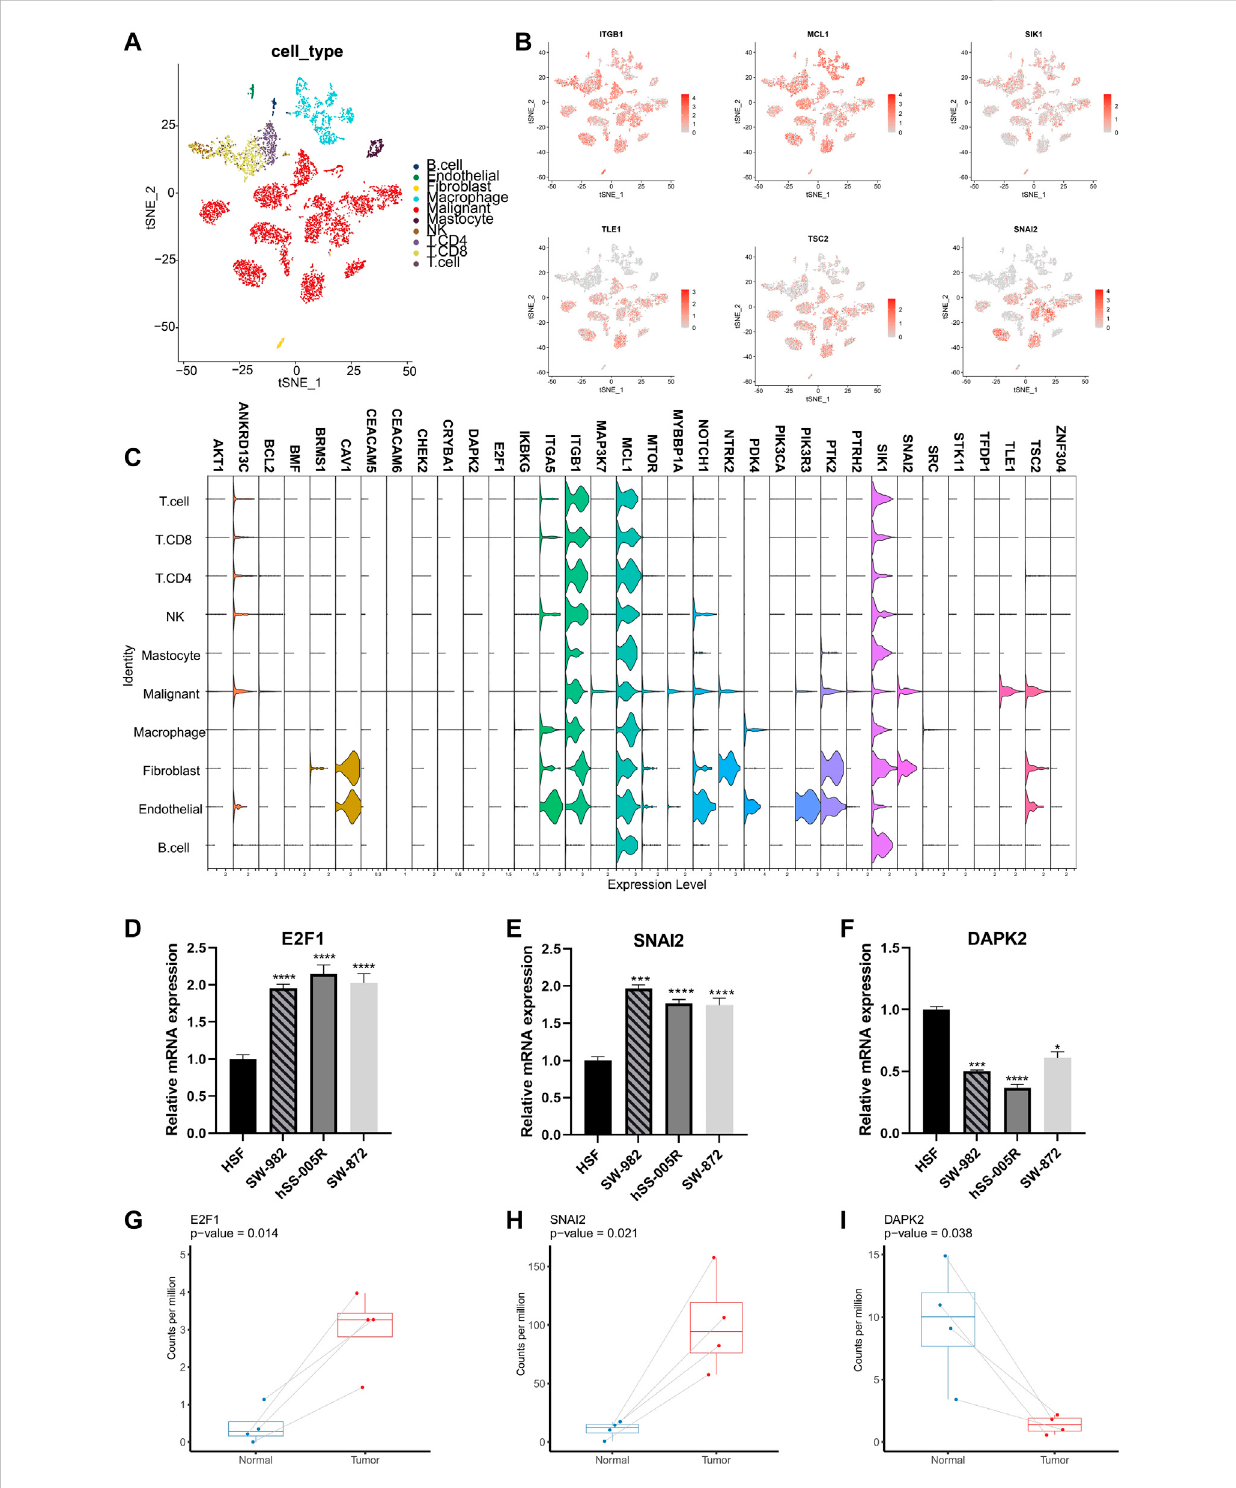
FIGURE 3 Validation of expression patterns of ARGs at single-cell resolution. (A) The t-distributed stochastic neighbor embedding (t-SNE) plot showing speci fi c cell types of STS. (B) The t-SNE plots showing the expression of ARGs in different cell types. (C) The violin plots illustrating expression levels of ARGs across different cell types. (D – F) Validation of expression of ARGs between STS cell lines and the control cell line by the real-time PCR. Real-time PCR experiments wererepeated using three biological replicates. (G – I) The box plots illustrating the expression of ARGs between STS and matched adjacent normal tissues based on our own sequencing data. *, 0.01 ≤ p < 0.05; ***, 0.0001 ≤ p < 0.001; ****, p <